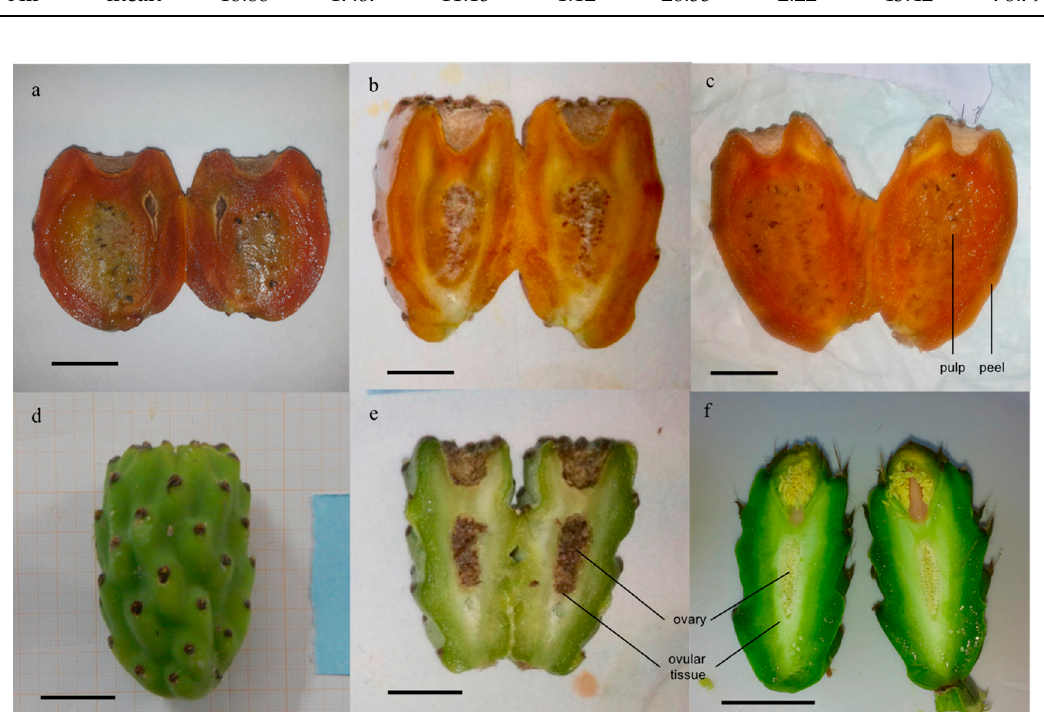
Figure 1. Main defects of harvested fruits: ( a ) lignification on pulp tissue; ( b ) lignification of ovary tissue; ( c ) healthy fruits; ( d ) recalcitrant fruits and ( e ) its longitudinal section; ( f ) longitudinal section of floral bud. Scale bar = 2 cm.